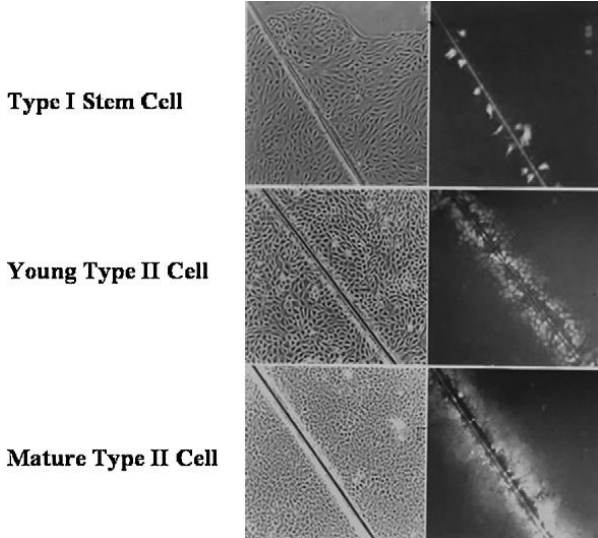
Figure 7. Using the scrape loading/dye transfer technique to measure GJIC by the diffusion of Lucifer yellow through functional gap junctions, these photographs illustrate that normal human adult breast stem cells do not have functional GJIC, while those human breast epithelial cells derived from the breast stem cells do have functional gap junctions. Permission granted from Trosko, J.E. and Chang, C.-C. [22].